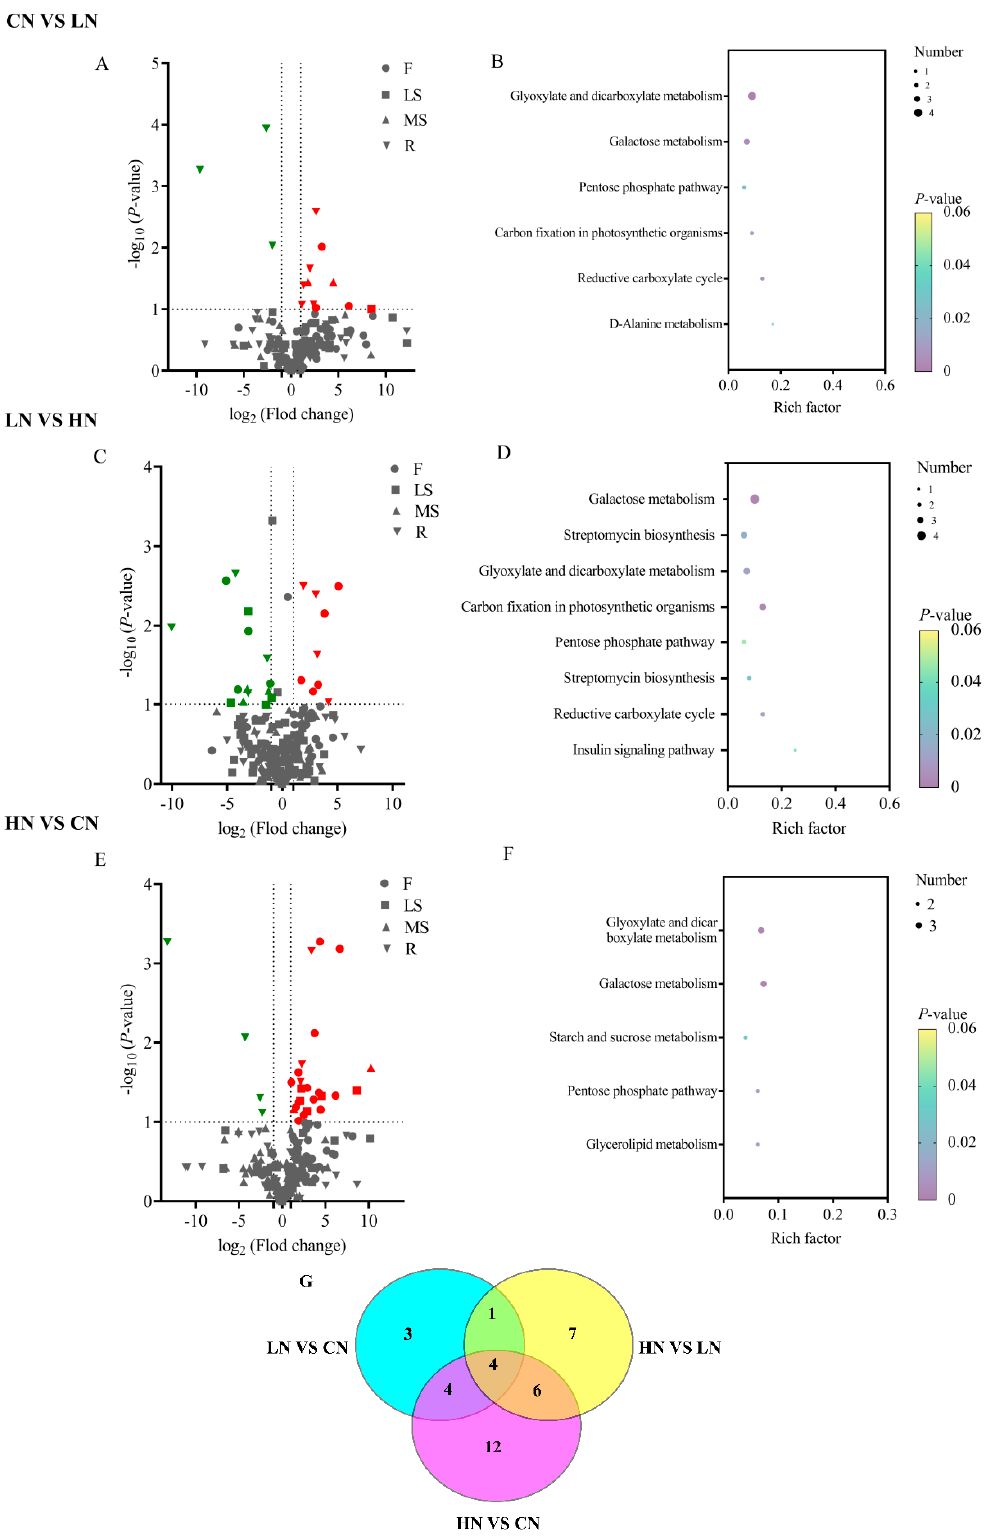
Figure 5. ( A – F ) The volcanic map of differential metabolites and enrichment analysis of the Kyoto Encyclopedia of Genes and Genomes (KEGG). The green and red represent metabolism contents that were down − regulated and up − regulated significantly under nitrogen fertilization, respectively. High nitrogen (HN) groups, low nitrogen (LN) and control nitrogen (CN); ▼ represents roots; ▲ represents main shoots; ■ represents lateral shoots; ● represents flowers. The p − value means degree of enrichment; the smaller the p -value, the more significant enrichment degree. The size of the dot means the number of differential metabolites. ( G ) The Venn diagram of differential metabolites.